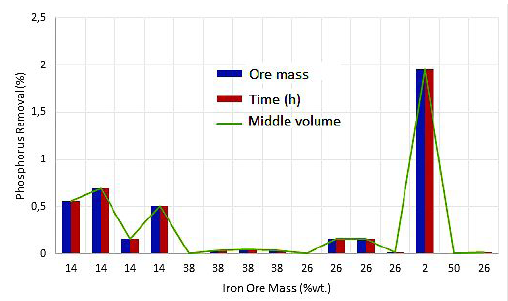
Figure 4. Contour plot of the response surface for phosphorus reduction of iron ore particles as a function of iron ore mass and time of contact with the sample.